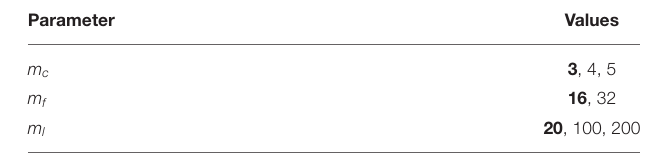
TABLE 1 | Combinations of hyperparameters of the leaflet autoencoder assessed during hyperparameter analysis. Parameter Values n c 3 , 4, 5 n f 16 , 32 n l 10, 20 , 30 The optimal combination is marked in bold.